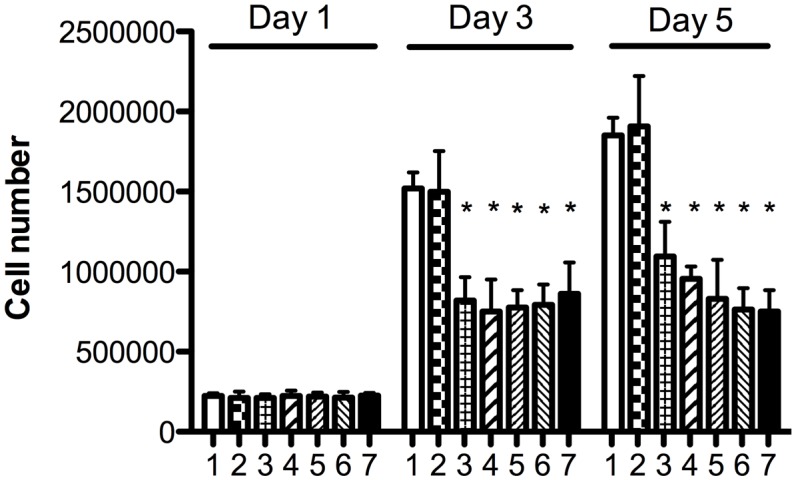
Cell counts at D1, D3, and D5 of corneal endothelial cells (CECs) grown in DMEM + F12 basal medium and seven different supplement combinations as detailed in Table 1.1: Complete SHEM; 2: complete SHEM with heparin; 3: 5% platelet releasate (PR) with heparin, without DMSO; 4: 5% heat-treated PR (HPR) with heparin, without DMSO; 5: 5% HPR without heparin or DMSO; 6: 5% PR with heparin and DMSO; and 7: 5% HPR, with heparin and DMSO. *p<0.05 vs. condition 1.